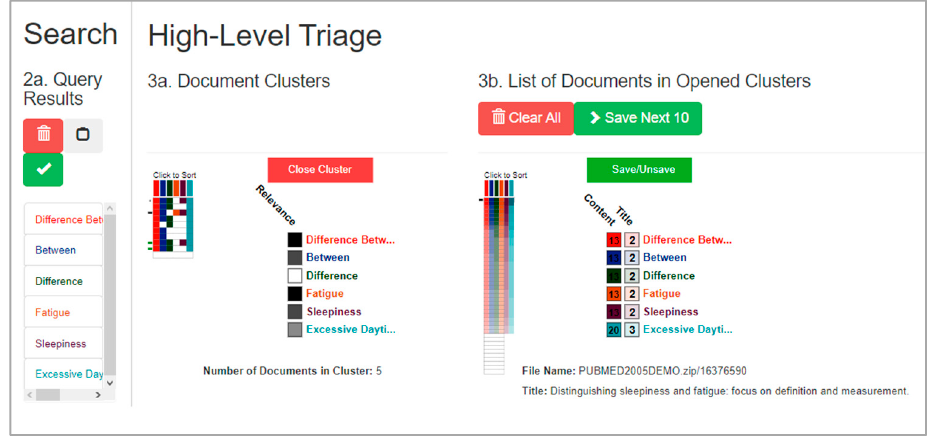
Figure 11. High-level triage after groupings have been inspected and opened for further examina-